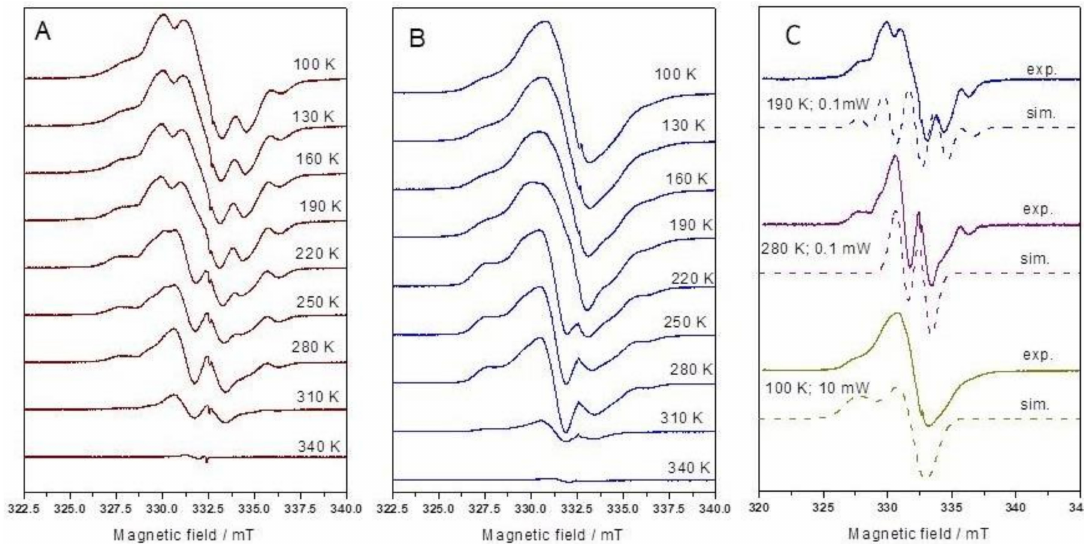
Figure 3. EPR spectra of human skin graft sterilized with a dose of 10 kGy at 77 K, then brought to 100 K and thermally annealed. The measurements were carried out at microwave power of ( A ) 0.1 mW and ( B ) 10 mW. ( C ) Experimental and simulated EPR spectra of hADM irradiated with a dose of 10 kGy at 77 K. Parameters used for simulations are given in the